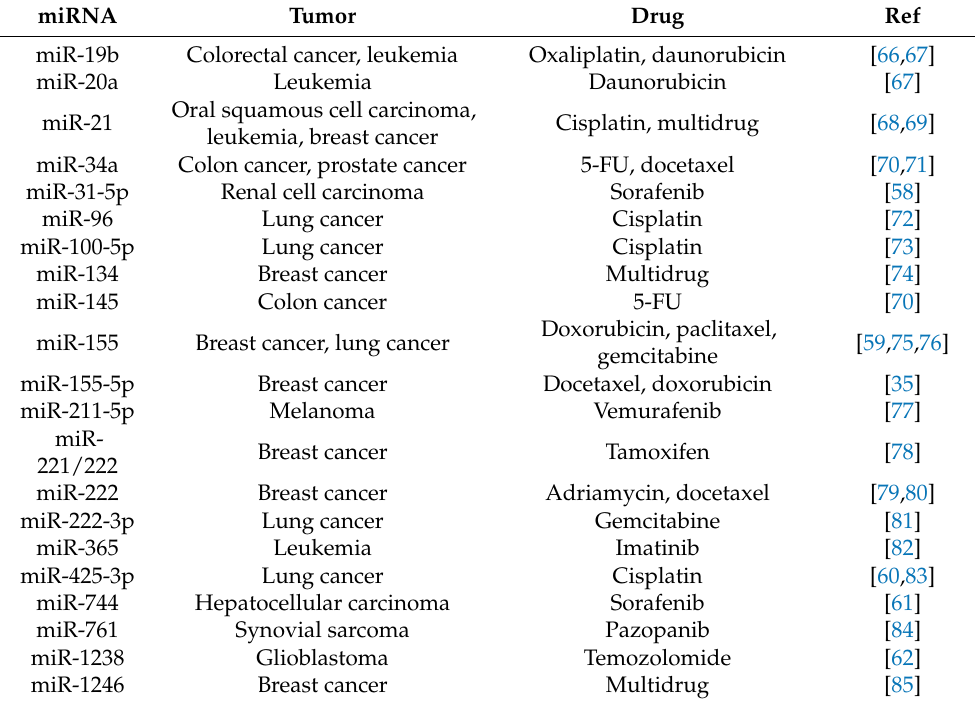
Table 1. Vesicular miRNAs involved in cancer drug resistance.